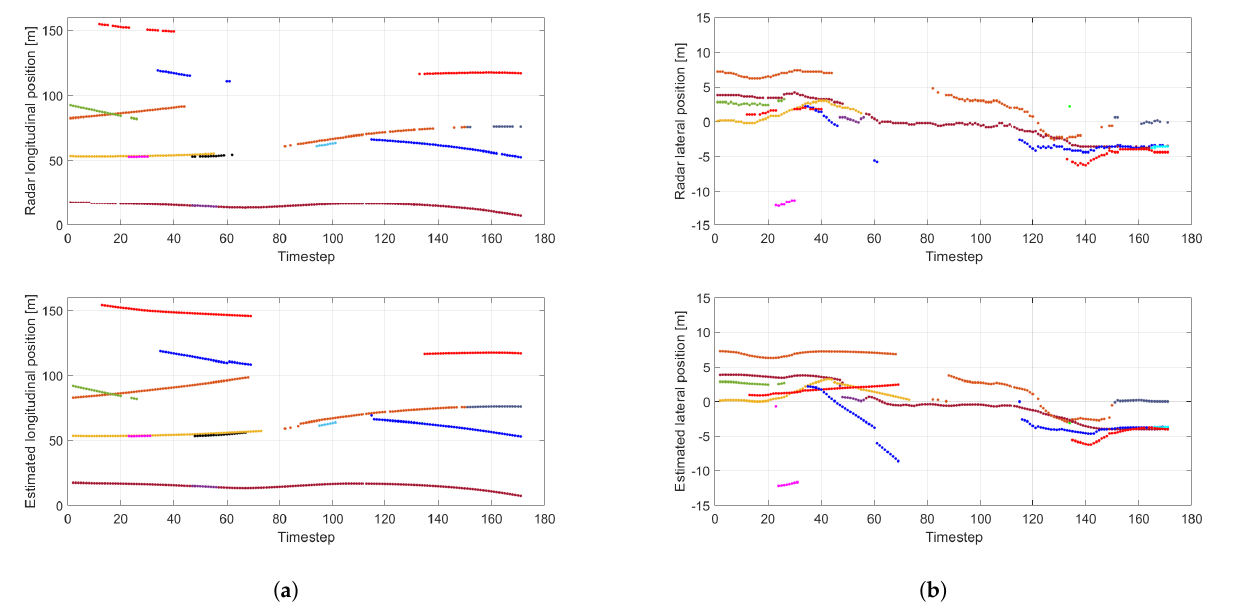
Figure 14. Lateral ( a ) and longitudinal ( b ) trajectory components of the detected objects. Top figures show raw radar measurements, bottom figures show estimated values.